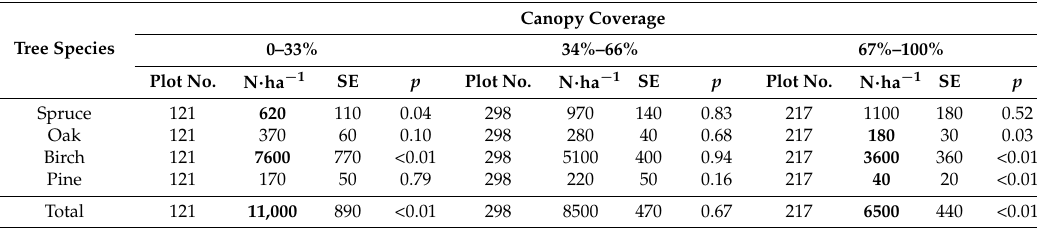
Table 6. Effect of canopy closure on seedling density in forest gaps. p -values refer to the comparison with all 636 regeneration plots in gaps 2014 (Table 3).